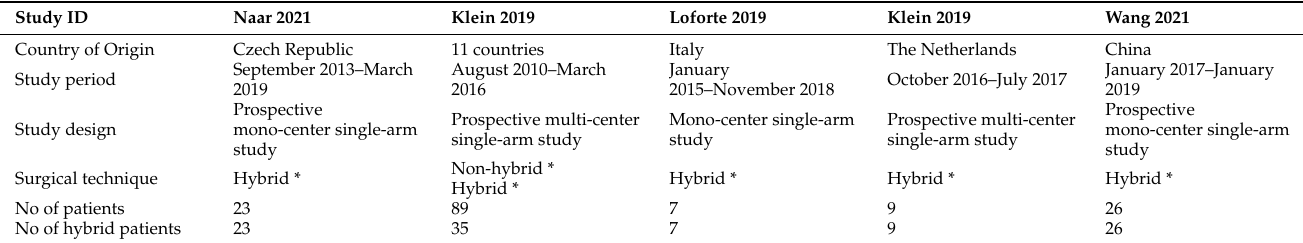
Table 2. Study characteristics of the included studies.